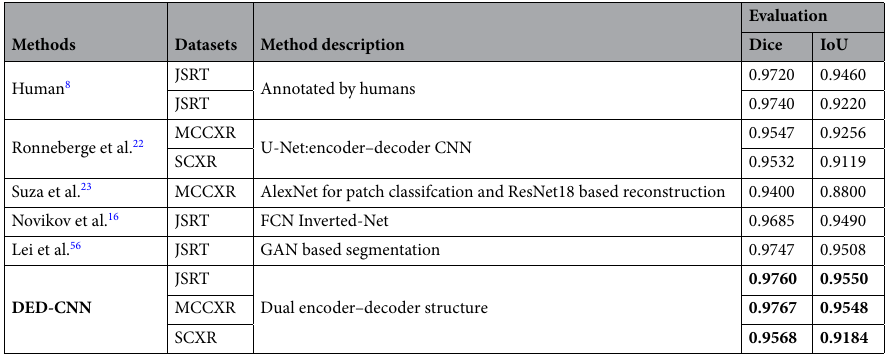
Table 5. Detailed comparison of the proposed method with the existing models using three different datasets. The bolded values represent the best performances.